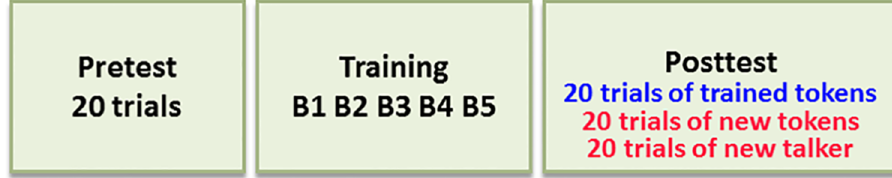
Fig 1. Procedure. Participants performed pre-test and five blocks of trainingon one of the protocols(each containedsixty trials) or no training. After that, participantsperformed a post-test with three conditions. Post- test performance on trained items is indicativeof learning(marked in blue). Post-test performances with the new talker and with new tokens are indicativeof generalization (marked in red).